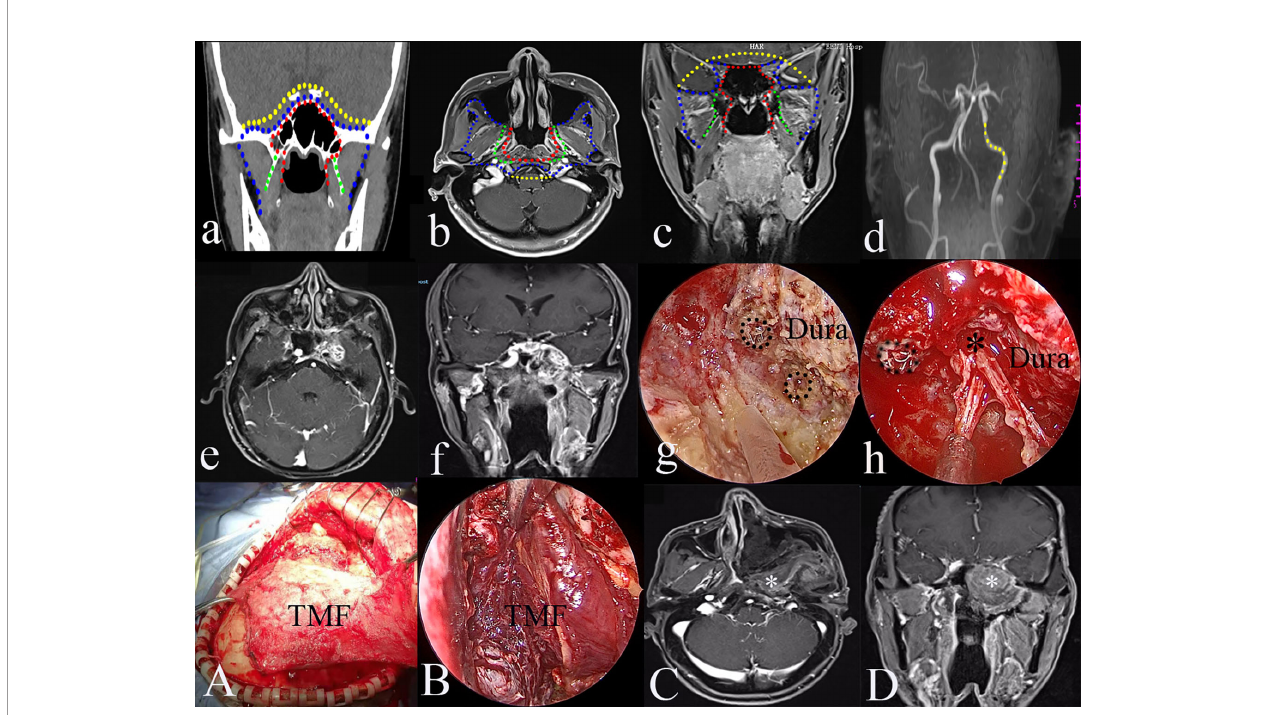
FIGURE 4 | The greatest extent of resection in Type IV transnasal endoscopic nasopharyngectomy (yellow dot line in a – d ); yellow dot line indicating the resectable internal carotid artery (ICA) (d) ; pre-operative magnetic resonance imaging (MRI) of rT4 nasopharyngeal carcinoma (NPC) (e) ; pre-operative MRA of left occluded ICA (f) ; resection of the involved ICA (black dot circle) (g) ; resection of the tumor in the Meckel ’ s cave (h) , black dot circle indicating resected ICA; the reconstruction of the skull defects using TMF (A, B) ; post-operative MRI indicating the total resection of the tumor (C, D) . black *, Meckel ’ s cave; white *, temporalis muscle fl